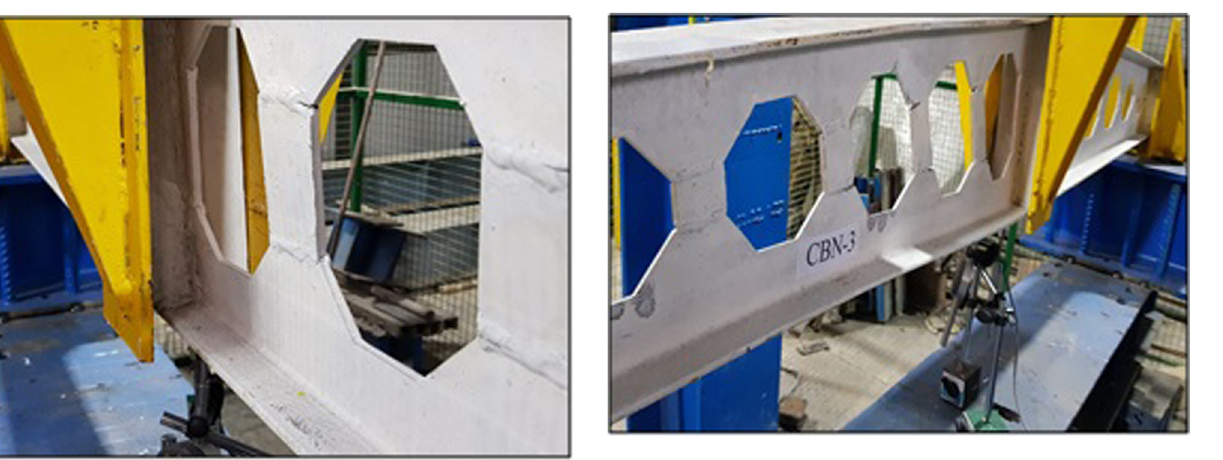
Figure 13: Failure mode of TCB ( web post buckling ) .